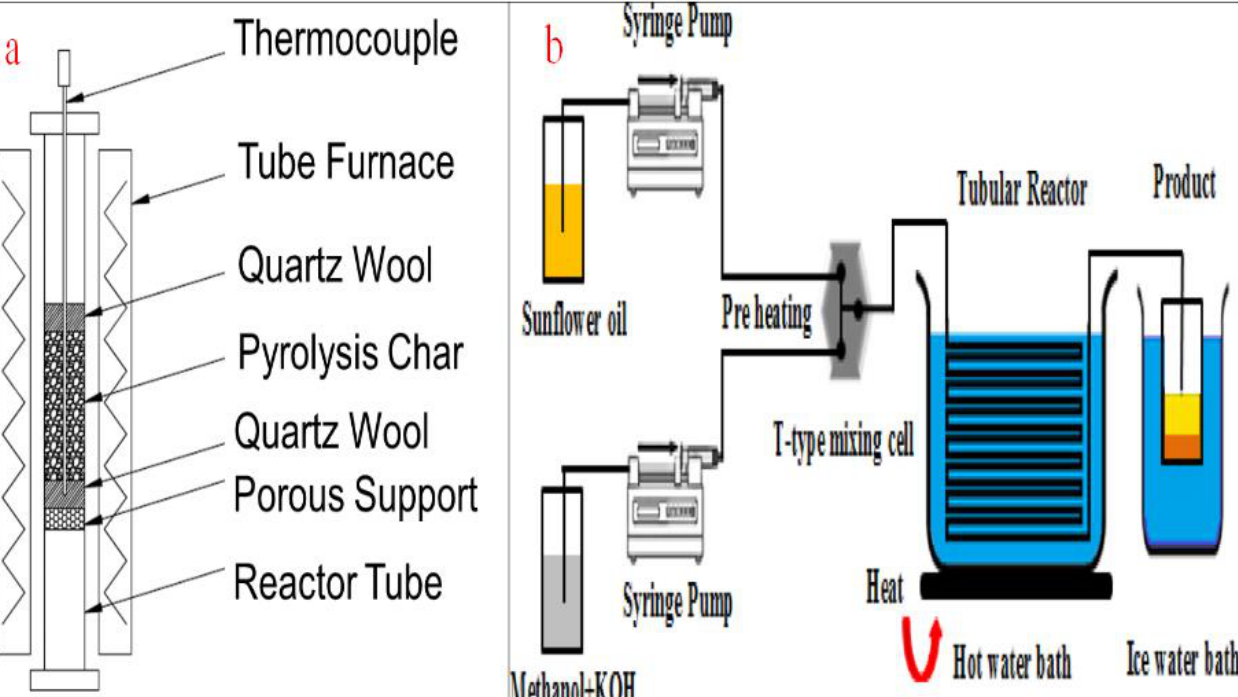
Figure 13. ( a ) Schematic representation of a micro channel reactor; ( b ) a micro channel for biodiesel production. Adapted from